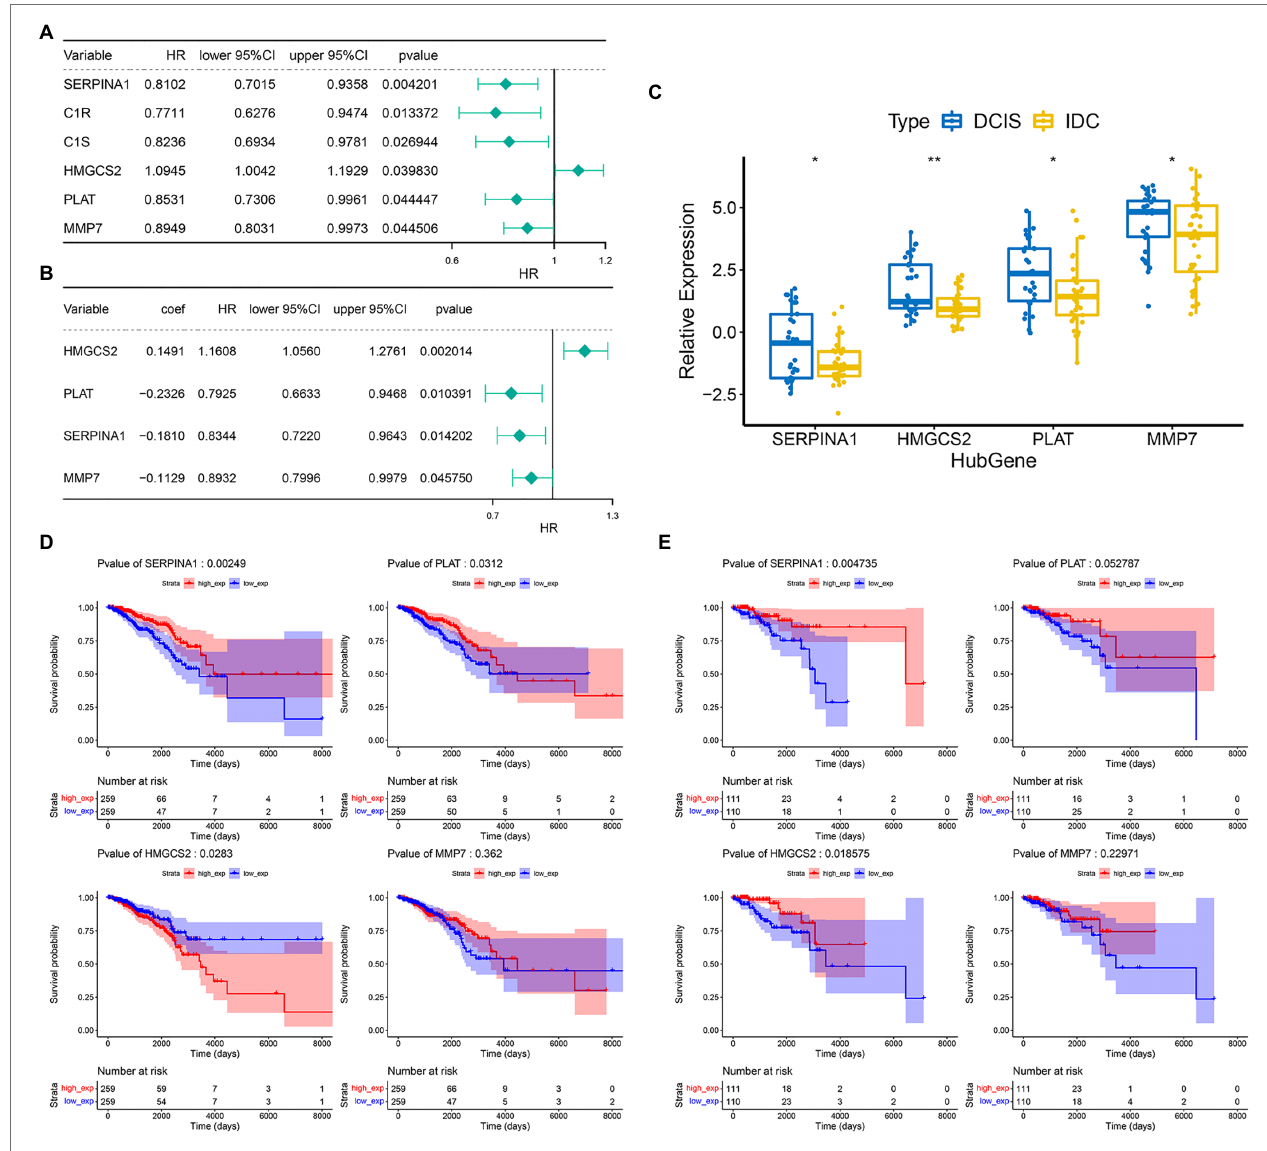
FIGURE 3 | Construction of prognostic gene signature of 4 COAGULATION-related genes in IDC. (A) Univariate Cox proportional risk regression forest plot including p -values, lower/upper 95%CI, and HR. (B) Forest plot for multivariate Cox regression analysis. (C) The expression levels of the four prognostic genes between the DCIS and IDC samples in the GSE26304 data set. (D) Kaplan–Meier survival curves of model genes in the training set. (E) Kaplan–Meier survival curves of model genes in the validation set. * p < 0.05 and ** p <